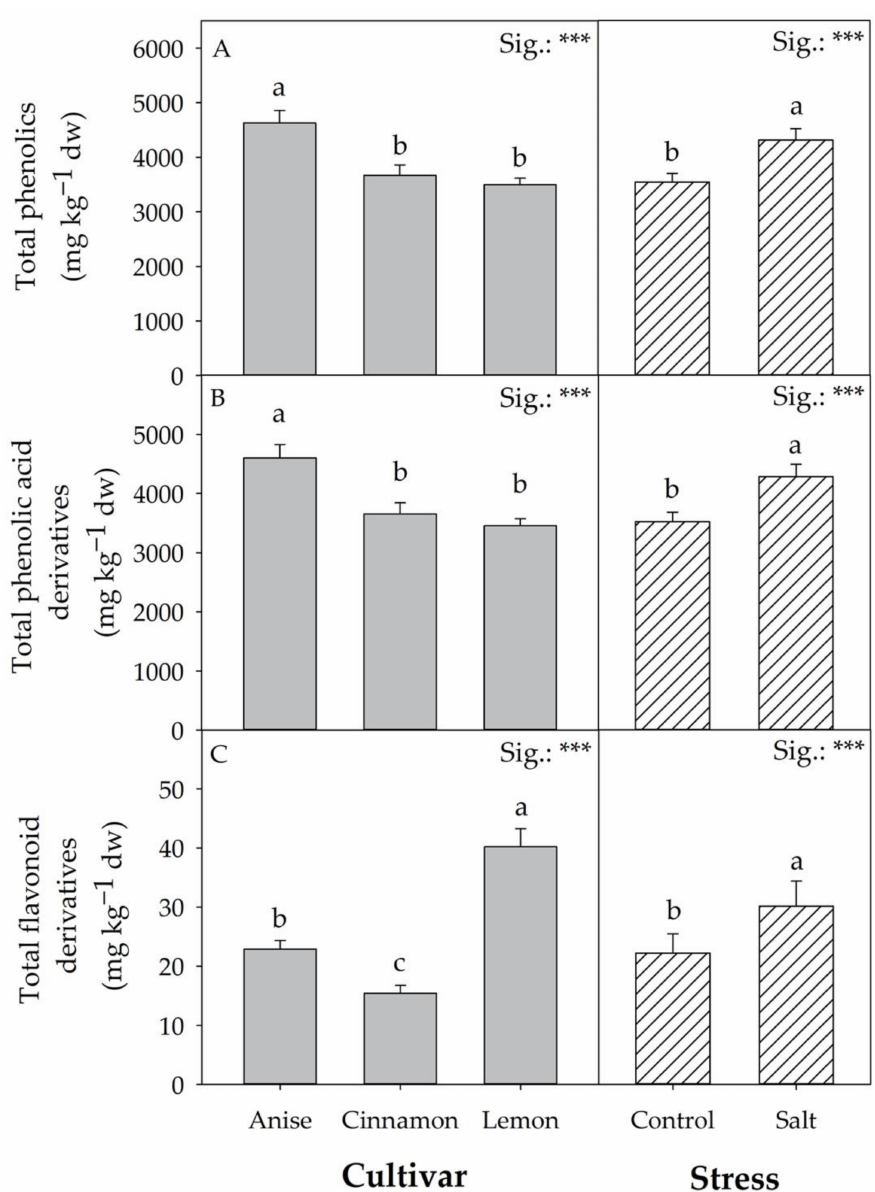
Figure 6. Effect of basil cultivars and stress on total phenolics ( A ), total phenolic acid derivatives ( B ), and total flavonoid derivatives ( C ). Data are mean values ± standard error, n = 3. Mean comparisons were performed by Tukey HSD test for CV and by t -Test for S. Different letters indicate significant mean differences. *** denotes significant effects at p ≤